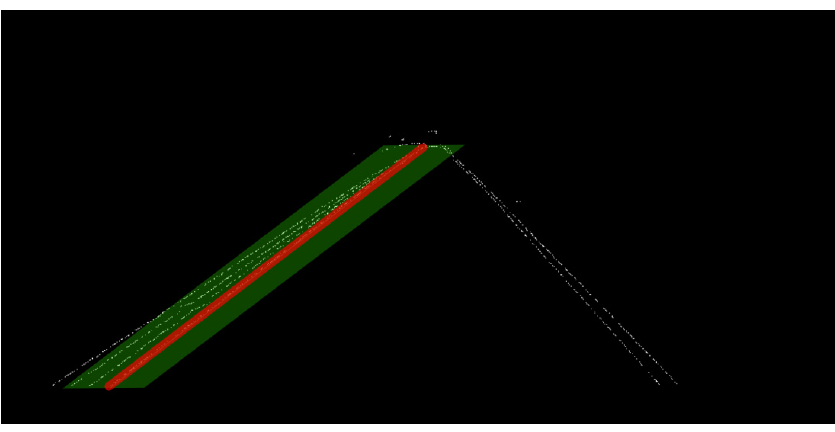
Figure 18. Parallelogram region of interest.